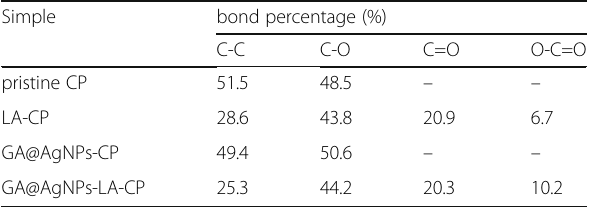
Table 1 Percentages of aliphatic C-C, C-O, C=O, and O-C=O bonds from XPS C1s peak fitting for pristine CP,